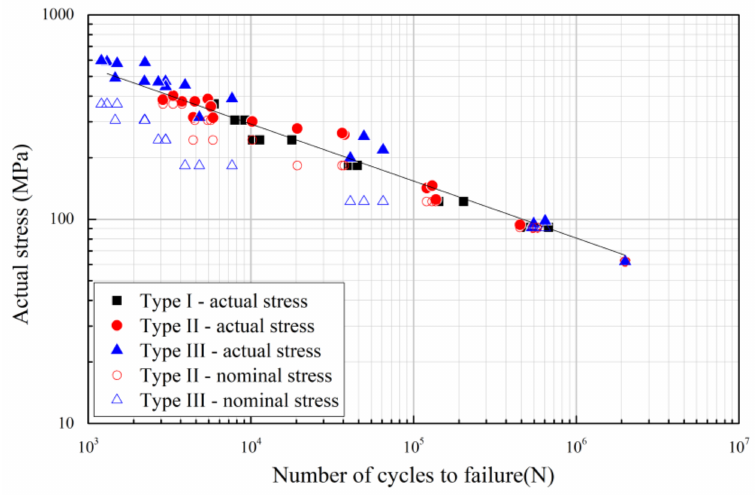
Figure 16. S – N curve derived using the actual stress from Equations (2) and